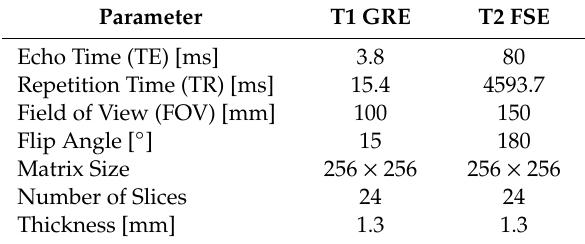
Table 1. MR scanning parameters for T1- and T2- weighted